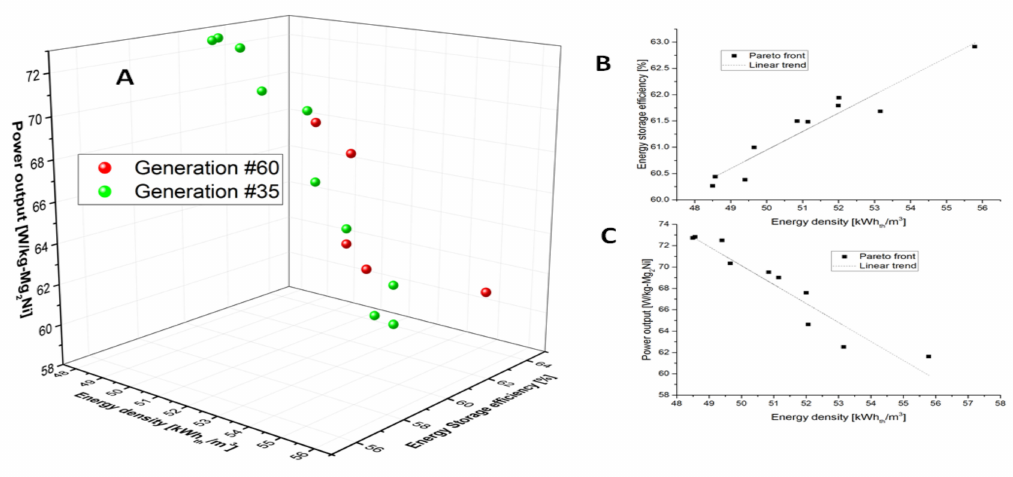
Figure 6. Pareto front of 10 potential optimal solutions: ( A ) 3D plot of the 3 objective functions. ( B ) 2D plot of energy storage e ffi ciency as a function of energy density. ( C ) 2D plot of power output as a function of energy